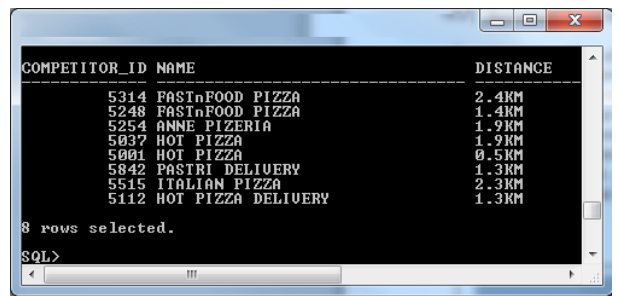
Figure 7. List of competitors within 3KM distance.